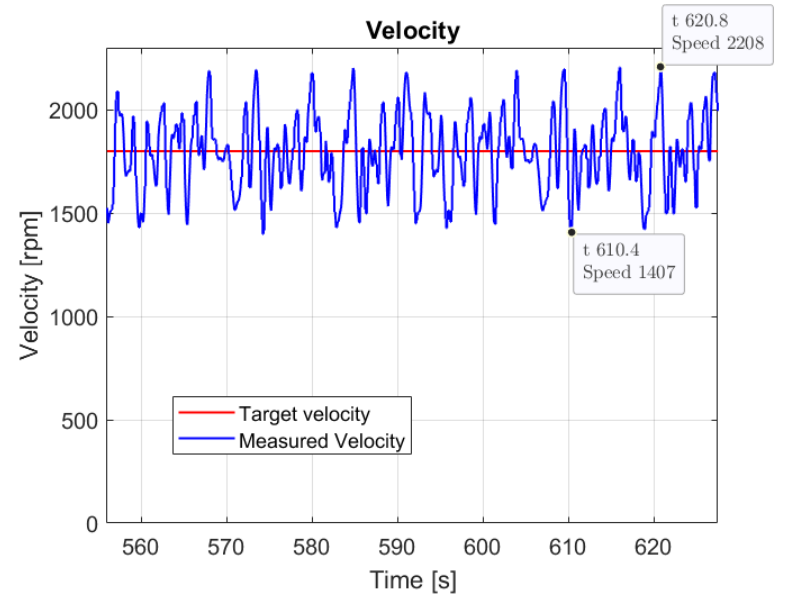
Figure 27. Target velocity and measured velocity.